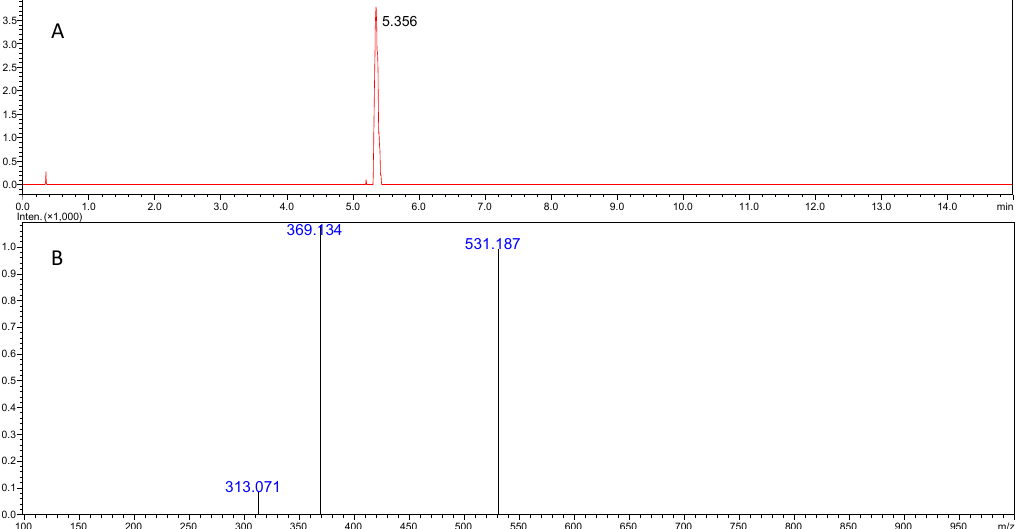
Figure 3. ( A ) Extracted ion chromatogram of sample JD for m / z = 677.2406–677.2474 corresponding to icariin. ( B ) MS/MS spectrum for the precursor ion m / z 677.249, at retention time 5.356 min, CE = 30 ± 15 eV. Fragments m / z 313.071, 531.191and 369.136 confirm presence of icariin in the sample.